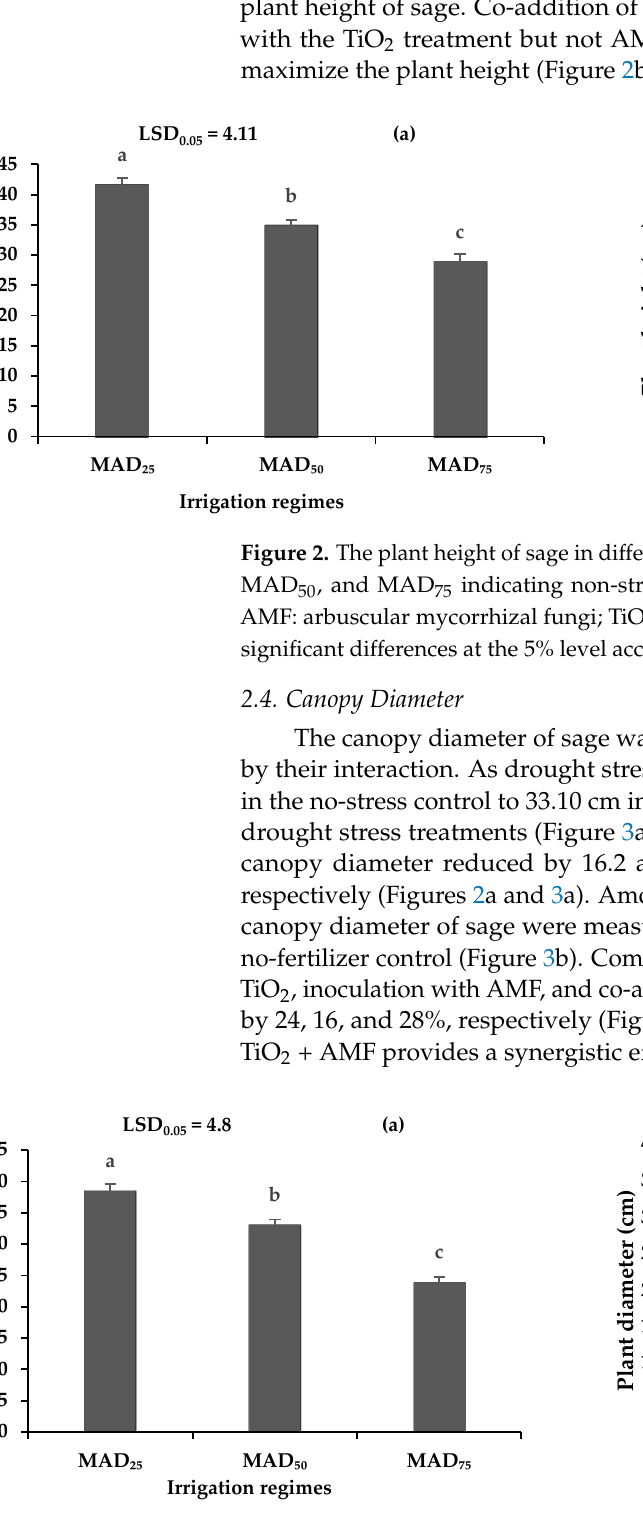
Figure 3. The plant diameter of sage in different irrigation regimes ( a ) and fertilizer sources ( b ). MAD 25 , MAD 50 , and MAD 75 indicating non-stressed, moderate, and severe drought stress, respectively. AMF: arbuscular mycorrhizal fungi; TiO 2 : titanium dioxide nanoparticle. Different letters indicate significant differences at the 5% level according to LSD test.